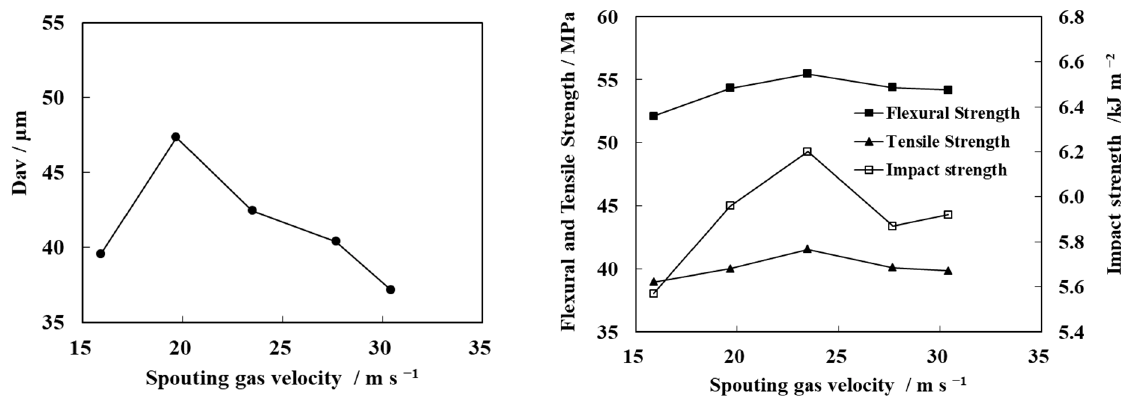
Figure 5. Effect of spouting gas velocity on the average particle size of modified N-WPCBs and the mechanical properties of PP/N-WPCB composites.